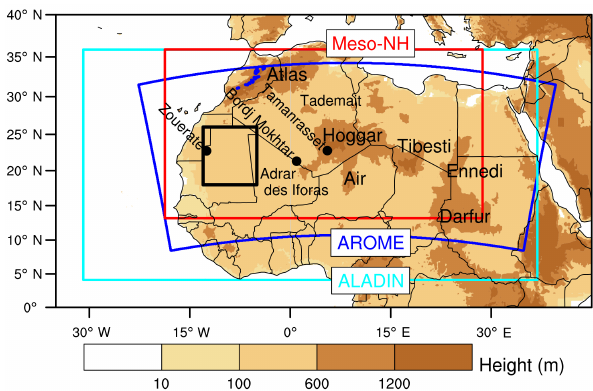
Figure 1. Topography of northern Africa. The locations of the do- mains of ALADIN, AROME and Meso-NH are indicated with cyan, blue and red lines, respectively. The black rectangle shows the area of interest where most of the SAFIRE Falcon 20 data were acquired. The location of the three AERONET stations used in this study are shown with black